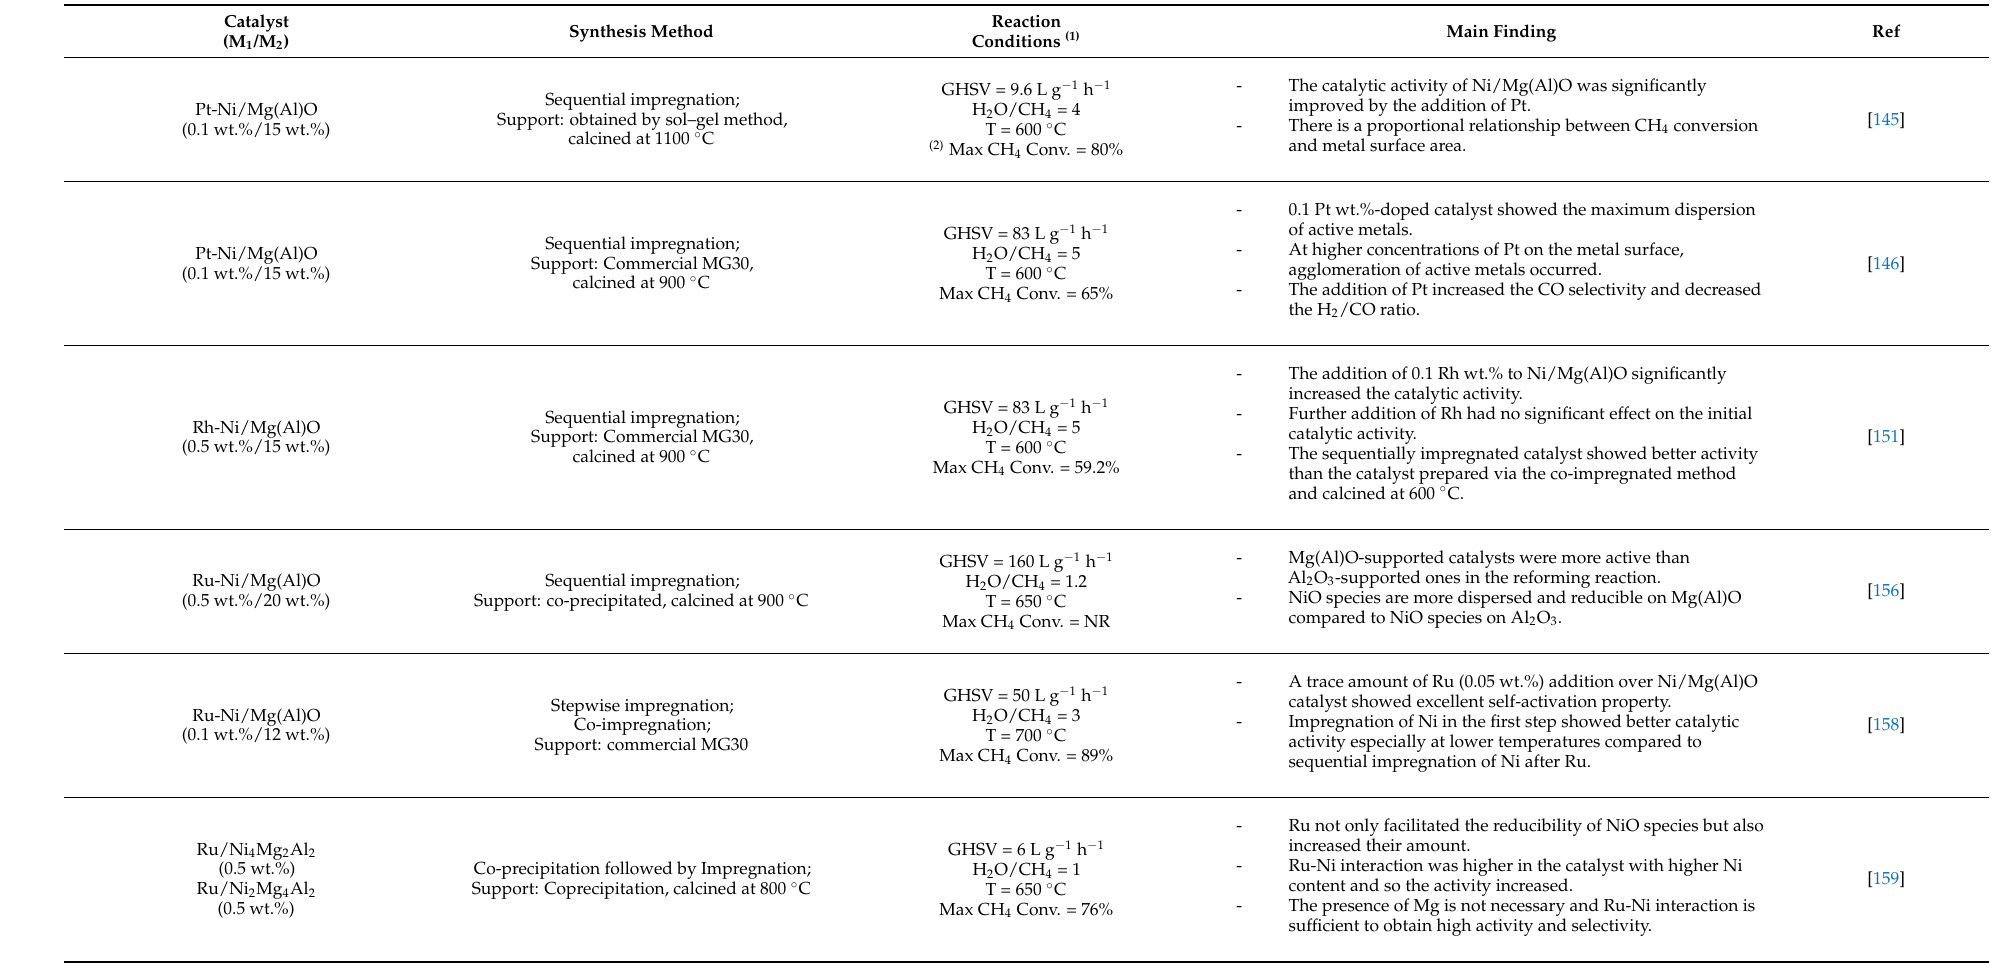
Table 5. Bimetallic Ni catalysts supported on Mg(Al)O for